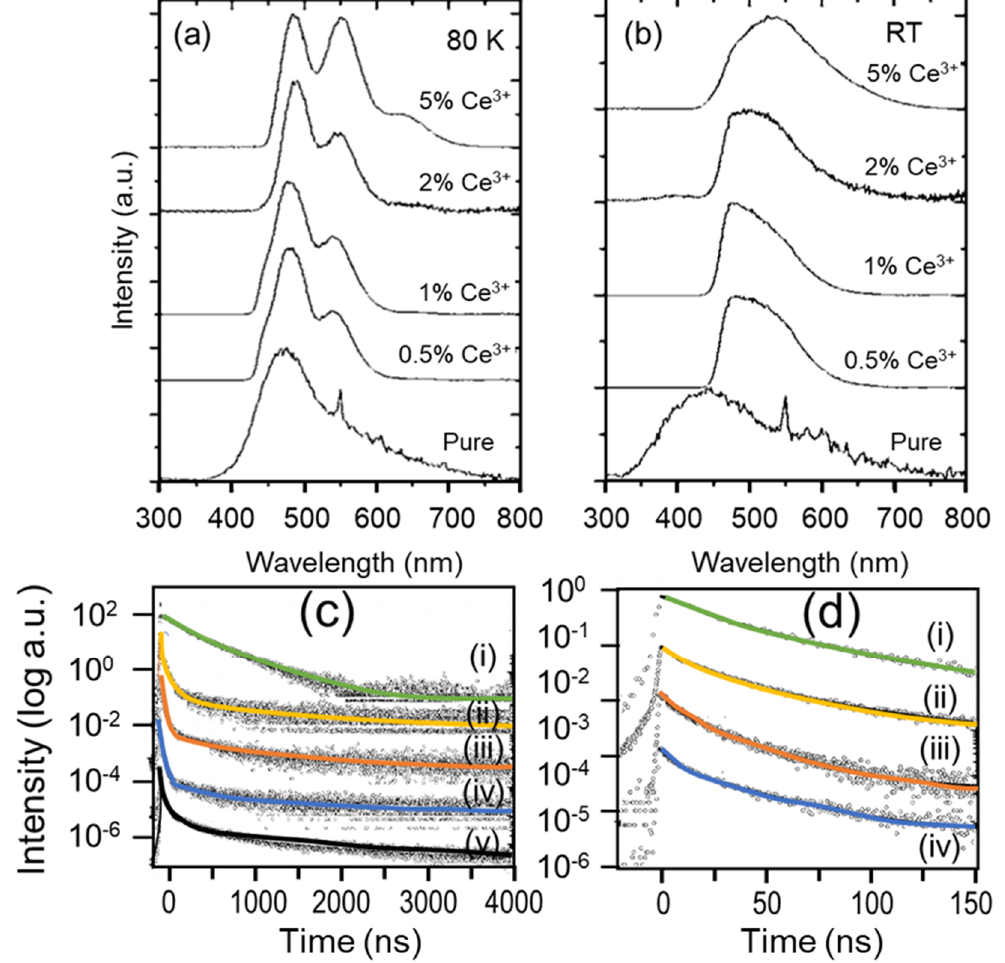
Figure 4. ( a , b ) Radioluminescence spectra of pure and 0.5%, 1%, 2%, and 5% Ce 3+ doped LuI 3 measured at 80 K and RT; ( c , d ) long-time scale and short-time scale scintillation decay curves recorded at RT of undoped (i), 0.5% (ii), 1% (iii), 2% (iv), and 5% Ce 3+ (v) doped LuI 3 . Reproduced from Reference [37] with permission.